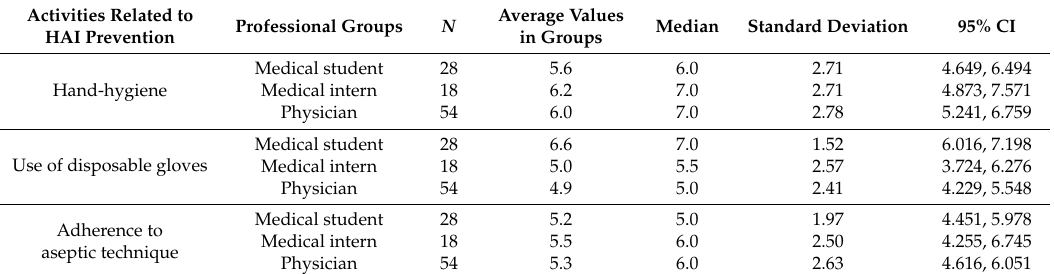
Table 2. Main measures to prevent healthcare associated infections according to professional groups.